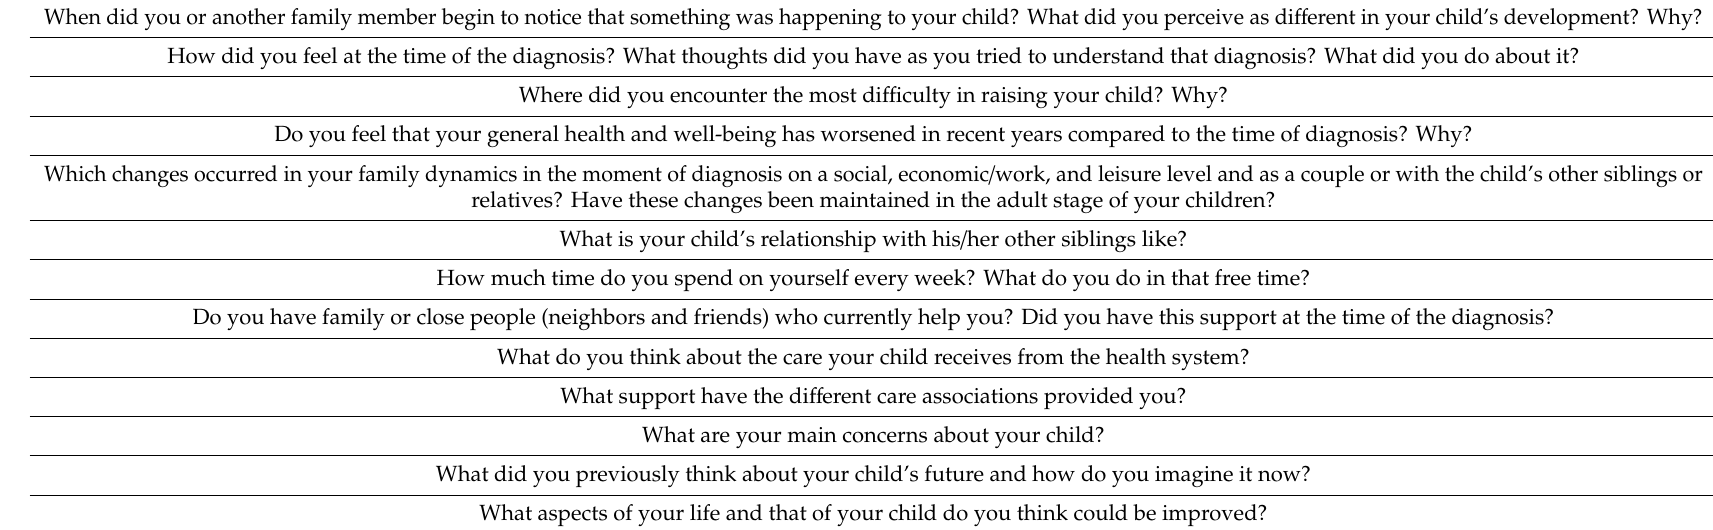
Table 2. Semi-structured interview schedule.